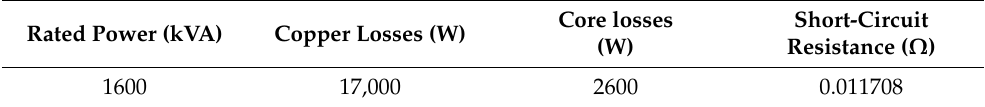
Table 4. Nominal features of Ormazabal distribution transformers.